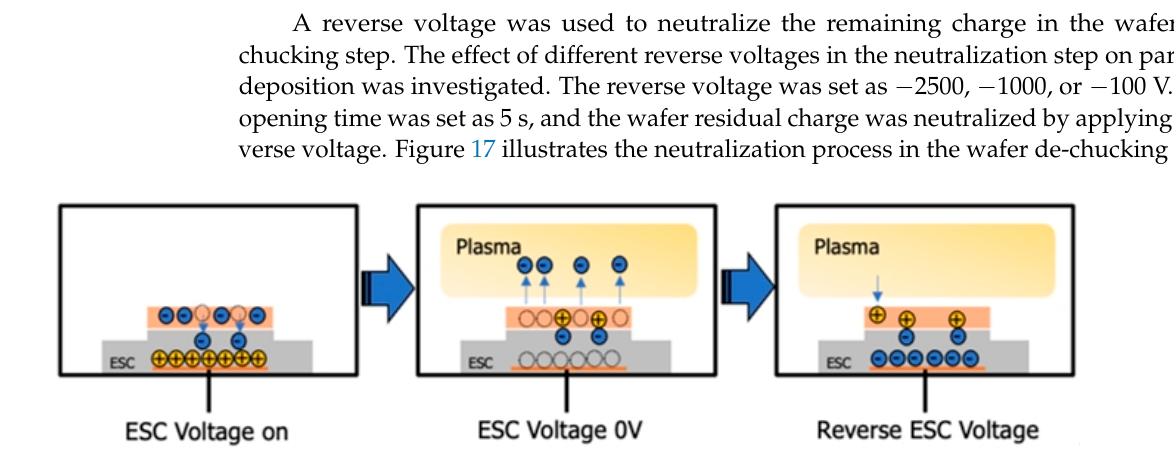
Figure 16. Particle deposition under increases and decreases in the temperature of the ESC.